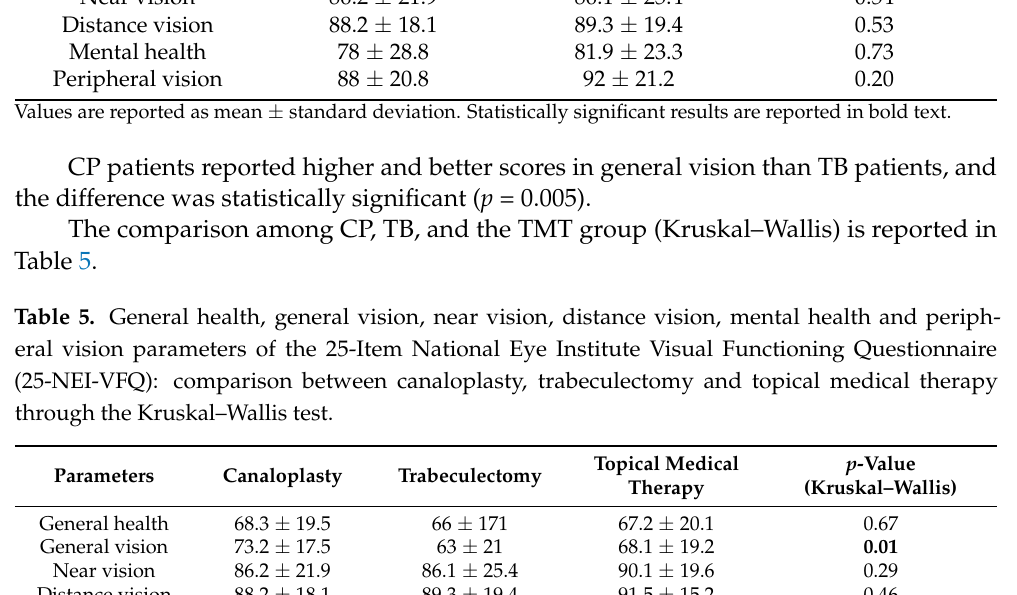
Values are reported as mean ± standard deviation. Statistically significant results are reported in bold